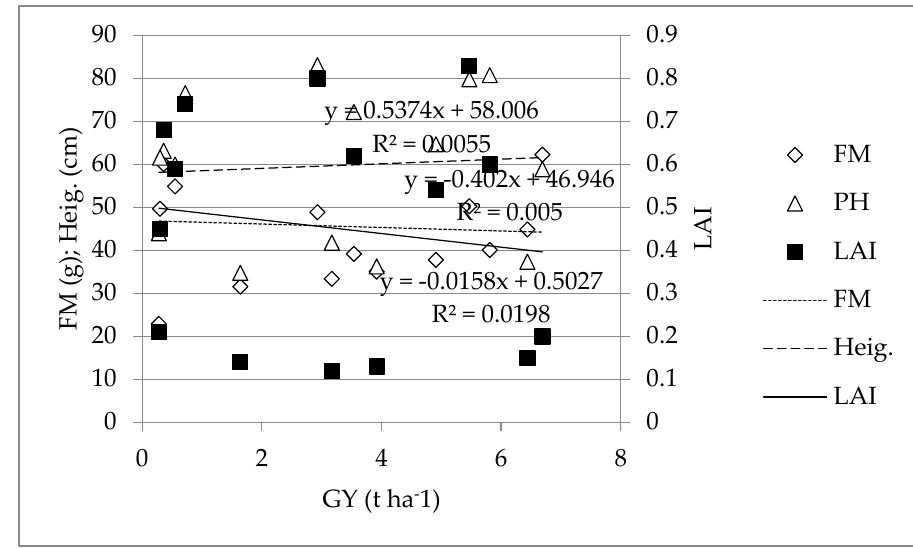
Figure 4. Correlation between grain yield (GY) and fresh matter (FM), plant height (Heig.) and leaf area index (LAI) 21 days after treatment (DAT) when FAA fertilizer was applied.